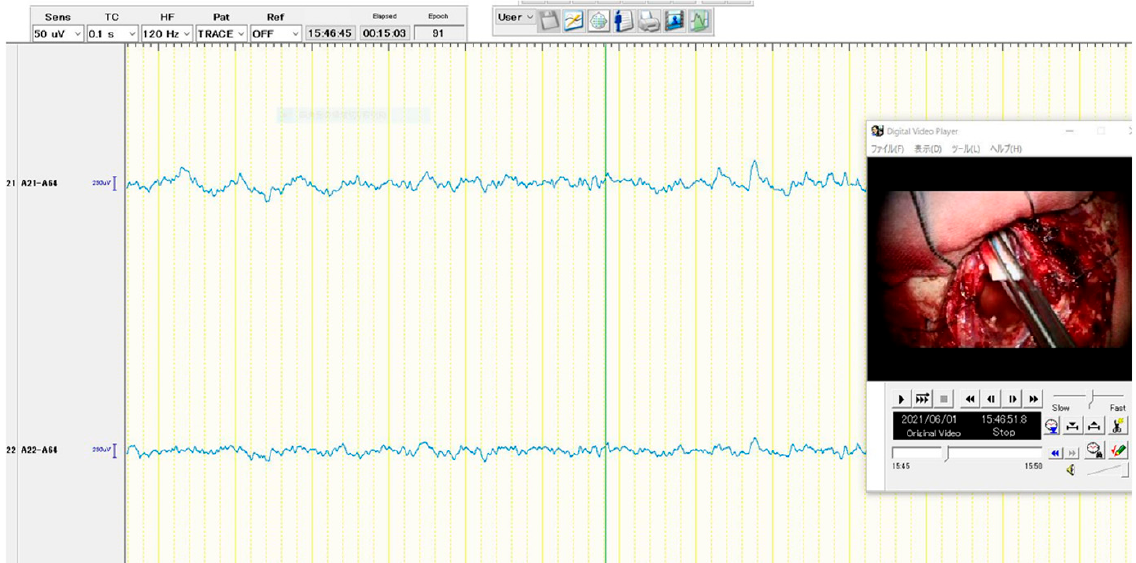
Figure 4. Intraoperative EEG patterns after resection of the tumor according to the referential recording. As a picture inside the figure depicts, a subdural grid was placed on the surface of the brain ahead of the resected cavity. The apparent epileptic discharges were not detected from this record.